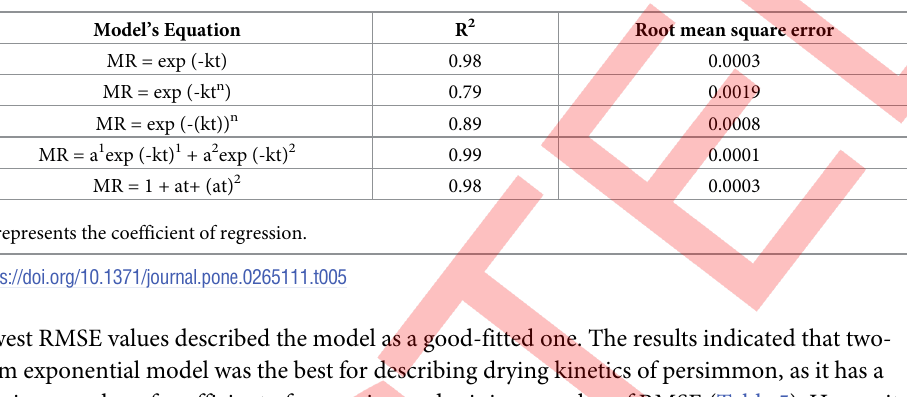
lowest RMSE values described the model as a good-fitted one. The results indicated that two- term exponential model was the best for describing drying kinetics of persimmon, as it has a maximum value of coefficient of regression and minimum value of RMSE (Table 5). Hence, it is recommended to apply a two-term exponential model on the moisture ratio of persimmon to get good results of correlation and regression and best fit.